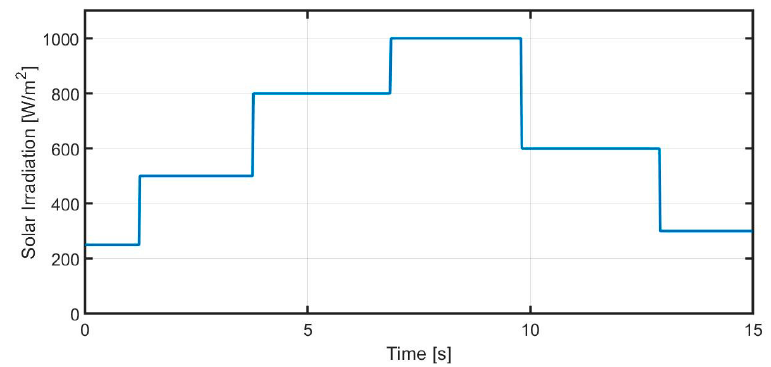
Figure 7. Time-varying and fast-changing dynamic solar irradiation signal.